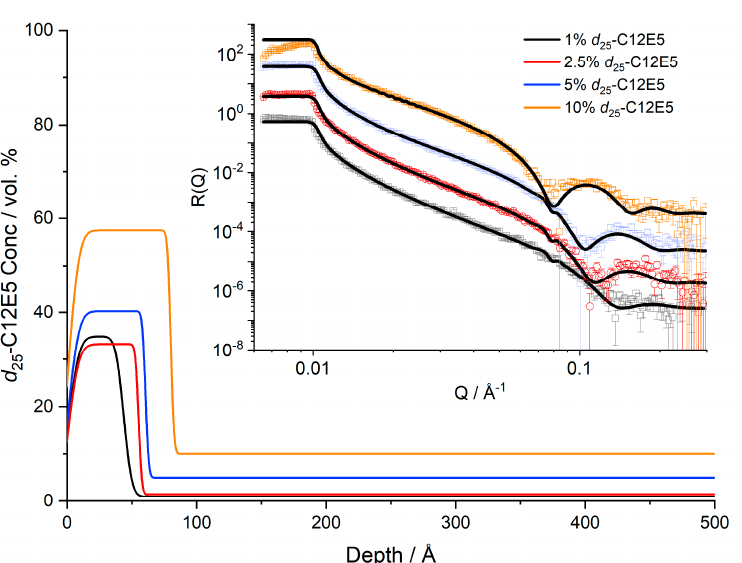
Figure 1. Near-surface concentration profiles of d 25 -C 12 E 5 in cis -PI at 20 °C. Reflectivity data and fits are shown in the inset, offset for clarity. Table 2. Surface excess for samples at 20, 45 and 60 °C and after rinsing for 10s and 20s with de-ionised water. NR data and fits used to obtain depth profiles are presented in Figures S5–8.